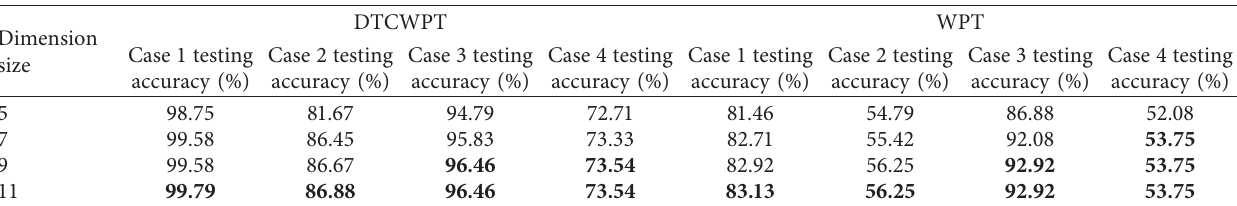
Table 8: Bearing fault diagnosis results obtained by OFS-LFDA-SVM.